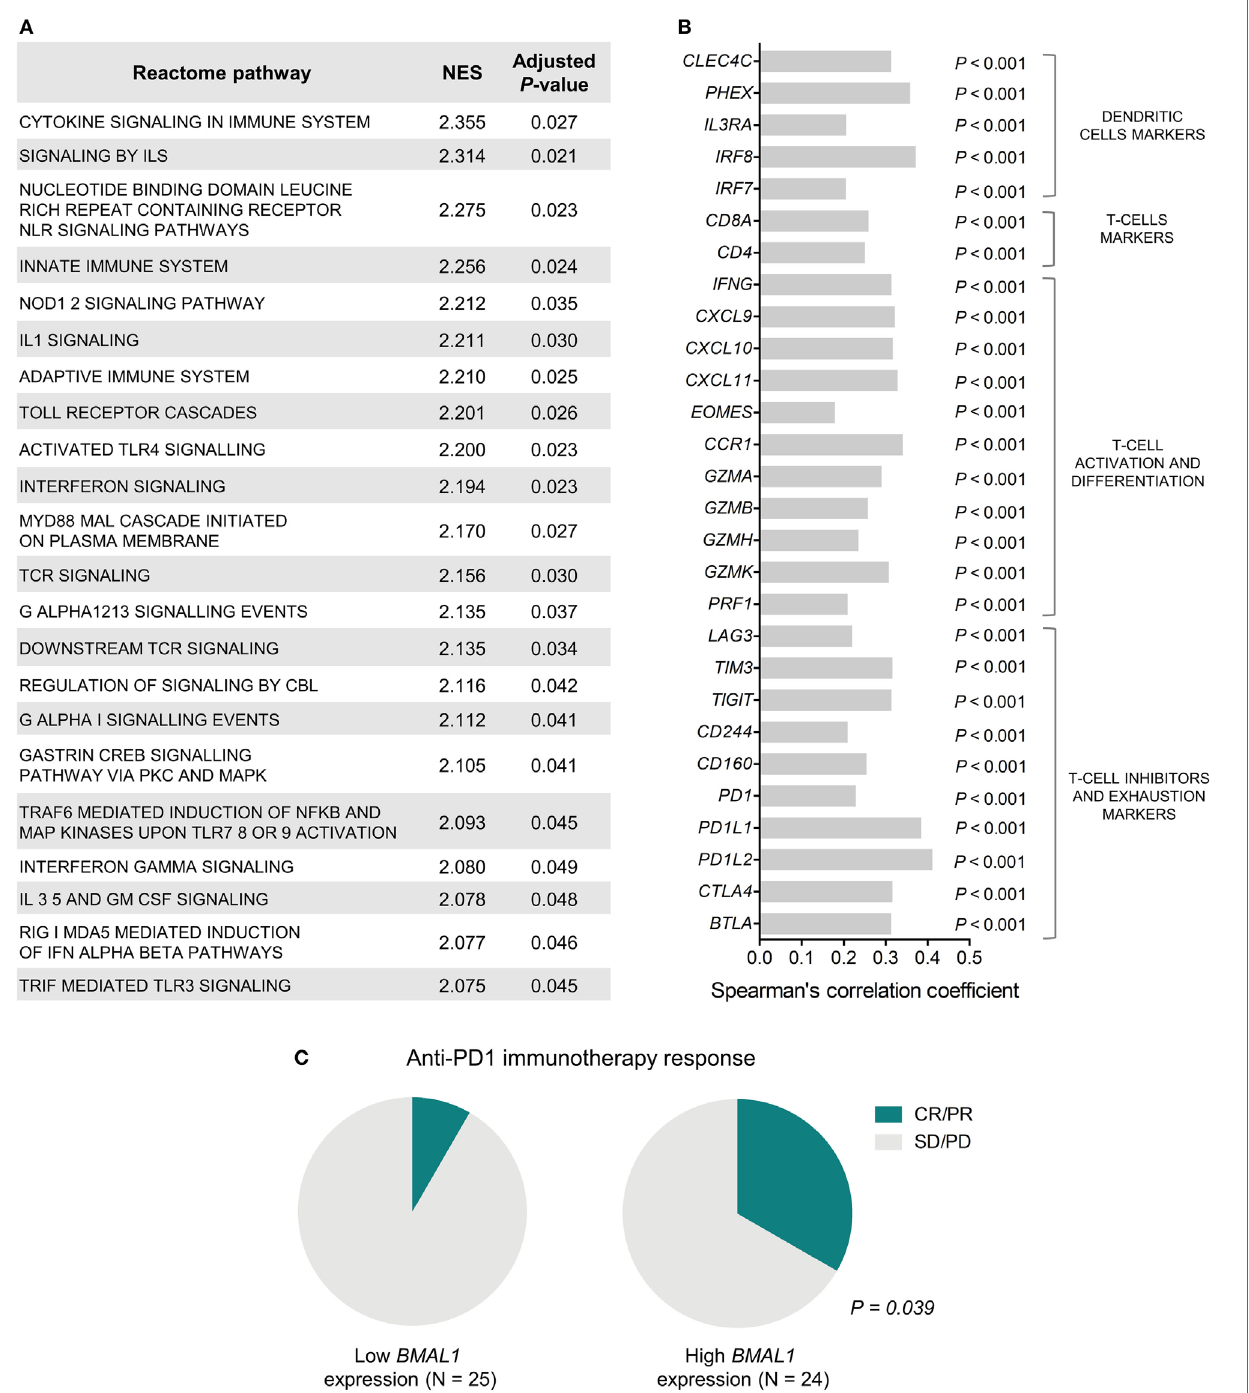
FigUre 2 | Aryl hydrocarbon receptor nuclear translocator-like protein 1 ( BMAL1 ) expression positively correlates with antitumor immunity in metastatic melanomas. (a) Gene Set Enrichment Analysis (GSEA) using genes ranked according to the Spearman’s correlation coefficient between their expression and the expression of BMAL1 in The Cancer Genome Atlas (TCGA) metastatic melanomas ( n = 340) . Normalized enrichment scores (NES) and P- values corrected by false discovery rate (FDR) were calculated using GSEA v3.0 and Reactome pathways. Only significantly enriched pathways (adjusted P < 0.05) are shown. (B) Spearman’s correlation coefficient between the expression of BMAL1 and immune cells markers in TCGA metastatic melanomas. P- values were corrected by FDR. (c) Association between BMAL1 expression (pretreatment biopsies) and clinical benefit of melanoma patients from anti-PD1 immunotherapy (nivolumab). RNAseq data and treatment response information were obtained from Ref. (42). Comparisons were performed using the Chi-square test. CR, complete response; PR, partial response; SD, stable disease; PD, progressive